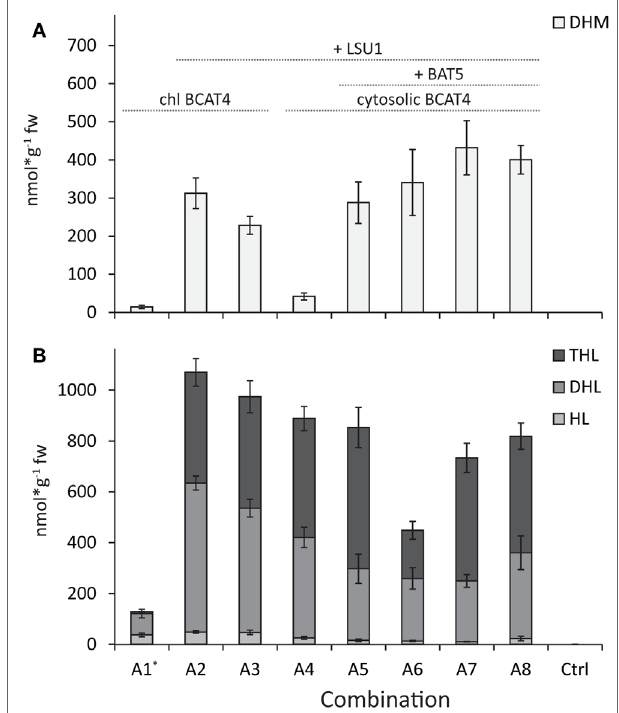
FigUre 2 | comparison of production of DhM and chain-elongated leucine-derived products . (a) DHM levels. (B) Levels of homo-leucine (HL), dihomo-leucine (DHL), and trihomo-leucine (THL). BCAT4 is relocalized to the chloroplast (chl BCAT4) in combinations A1–A3. The transporter protein BAT5 is coexpressed in combinations A5–A8 and the large subunit (LSU1) of IPMI is coexpressed in all combinations except A1. Ctrl represents non-infiltrated. Chl BCAT4 = BCAT4 with signal peptide for relocation to chloroplast, + LSU1 = combinations where LSU1 was coexpressed, and + BAT5 = combinations where BAT5 was coexpressed. Data are represented as mean ± SEM in nanomole per gram fresh weight ( N = 8).